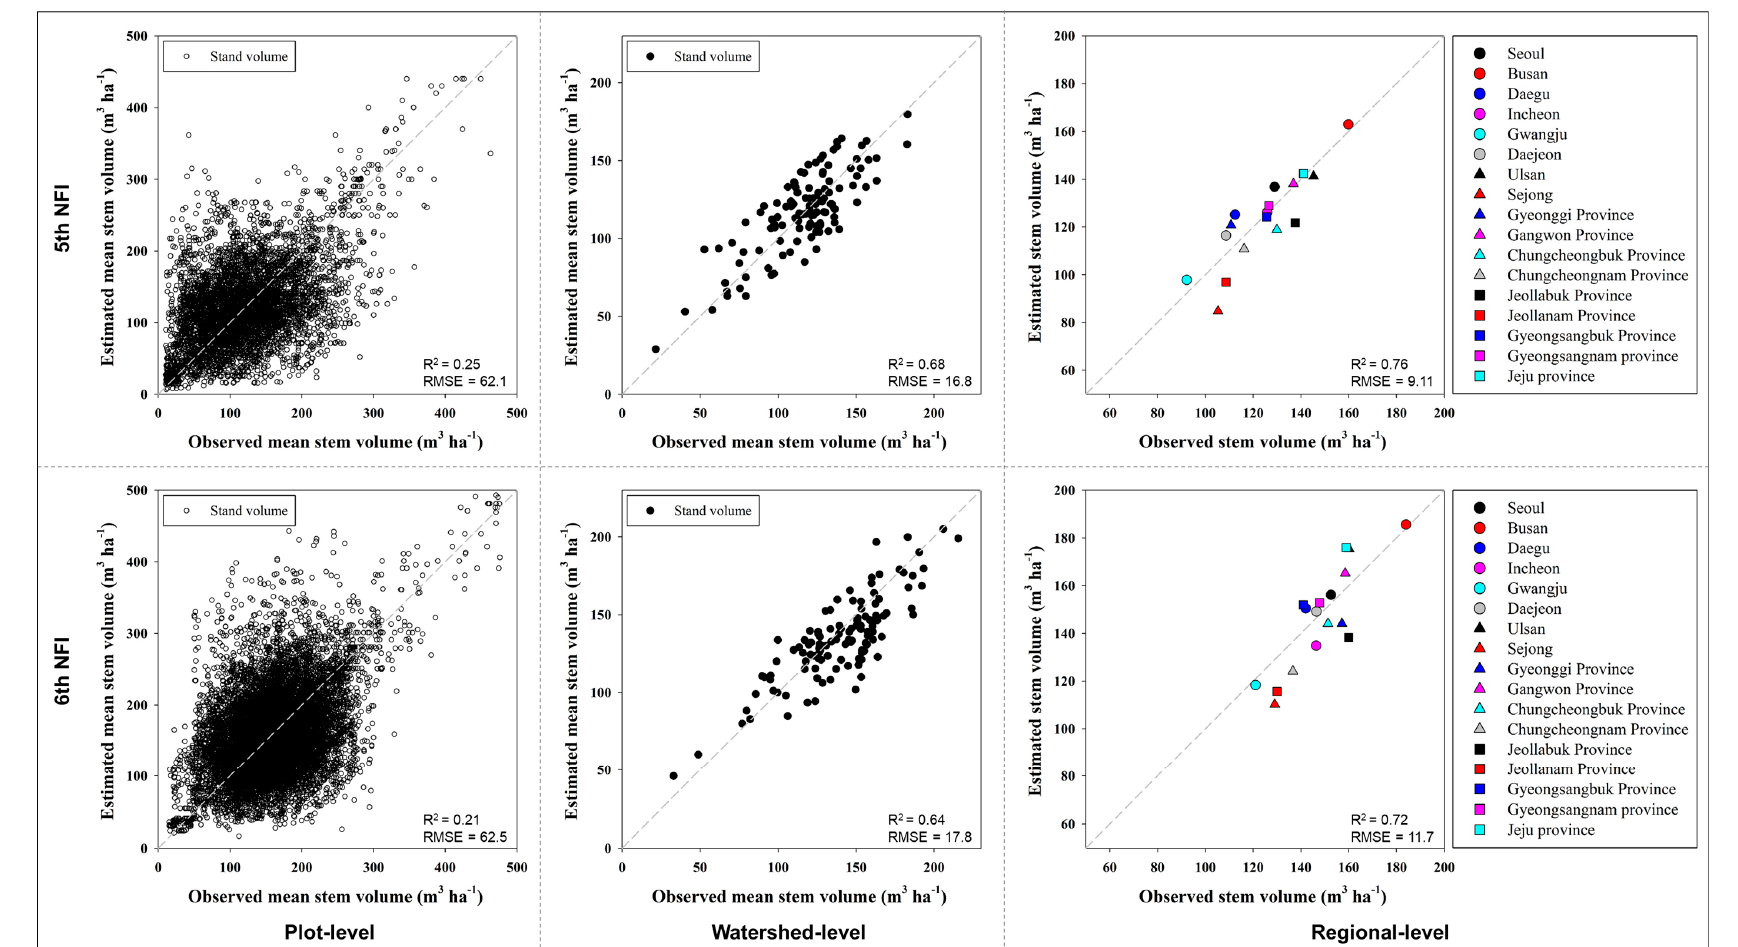
Figure 6. Observed and estimated stem volumes (m 3 ha − 1 ) at plot, watershed, and administrative levels.